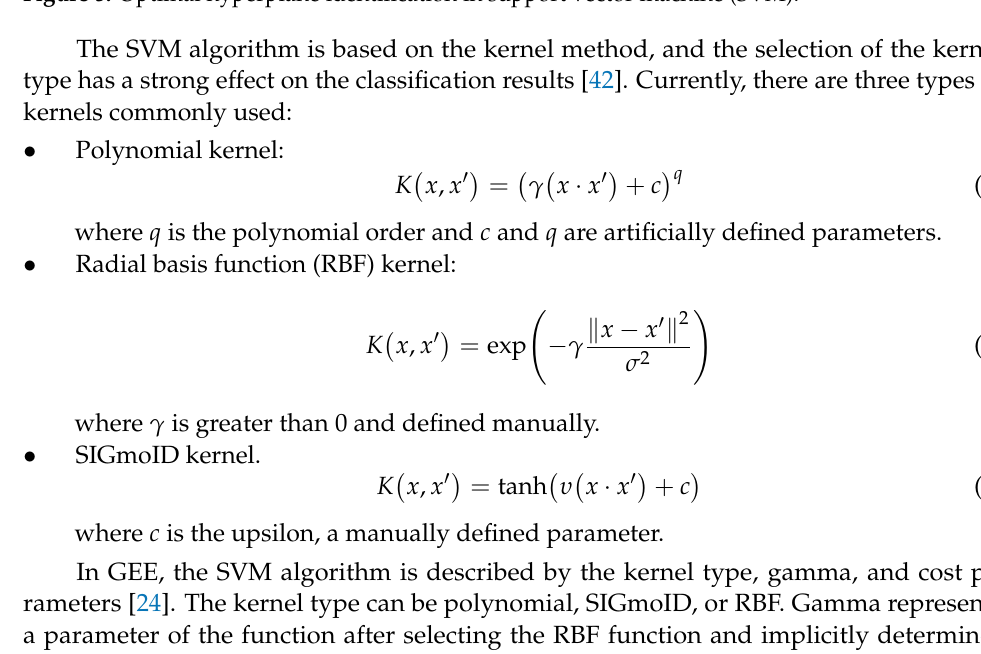
Figure 5. Optimal hyperplane identification in support vector machine (SVM).